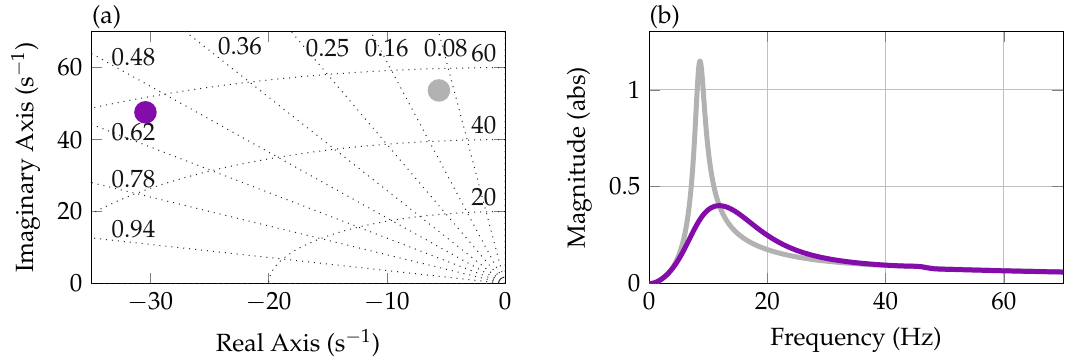
Figure 6. Open-loop ( ) and closed-loop ( ) pole location of the wing’s first bending mode depicted in ( a ). Magnitude plot of the wing model augmented with the blending vectors ( ) in ( b ) together with the magnitude of closed-loop (